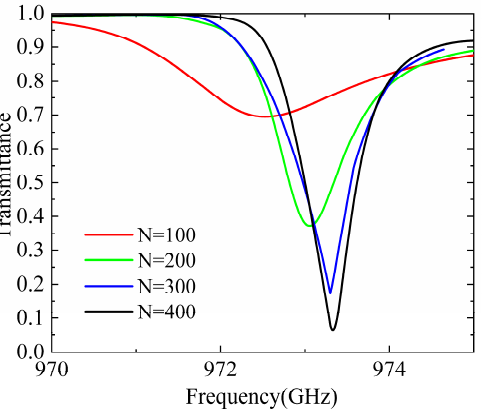
Figure 4. Transmission of a Gaussian beam through the composite grating with different number of grating elements. The grating element geometry is the same as before, i.e., W = 10 μ m, δ = 1 μ m, P = 97.2 μ m, t = 88 μ m and h = 10 μ m.